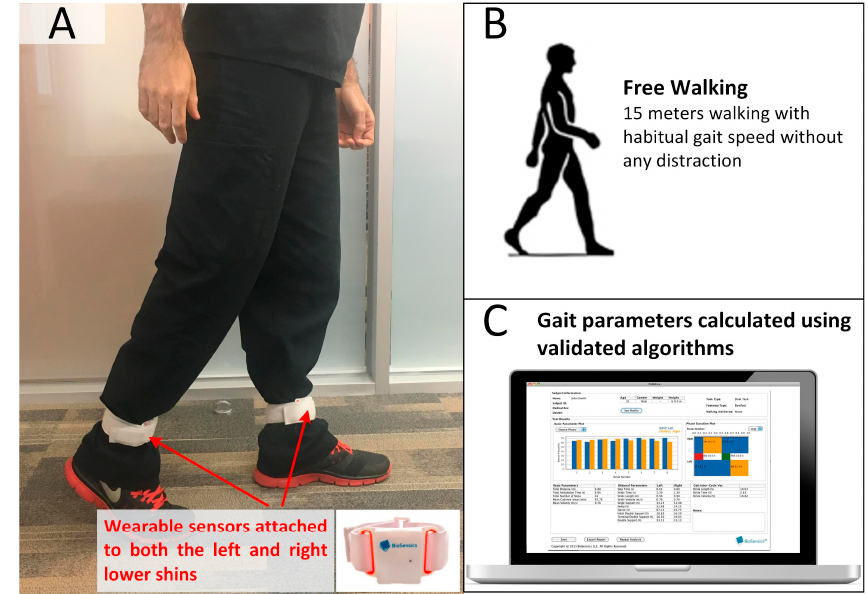
Figure 1. An Illustration of gait test. ( A ) Two wearable inertial sensors were attached to left and right lower shins. ( B ) The subject was asked to walk with habitual gait speed for 15 m. ( C ) Using validated algorithms gait parameters of interest, including stride velocity (unit: m/s), normalized stride velocity to height (unit: height/s), stride length (unit: m), normalized stride length to height (unit: % height),